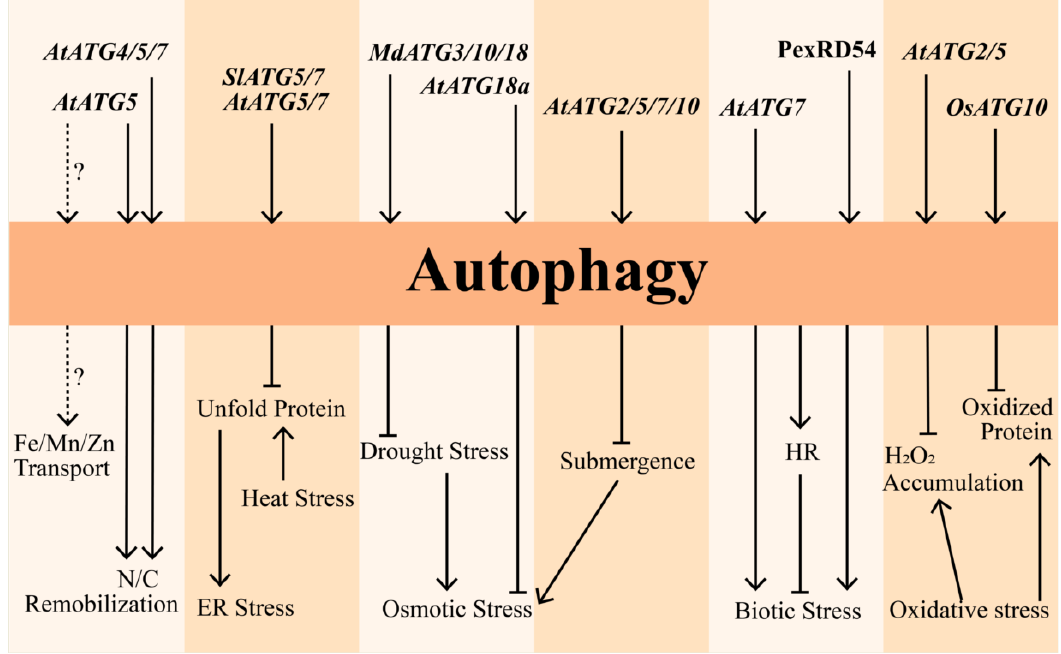
Figure 1. Regulation of stress response by AuTophaGy-related ( ATG )-mediated autophagy. Multiple ATG genes operate autophagy. AtATG5 positively regulates the nitrogen remobilization and tolerance to carbon starvation while AtATG4 and AtATG7 are known to modulate tolerance to carbon starvation. In addition, AtATG5 is also involved in regulating the homeostasis of micronutrients, such as Fe/Mn/Zn. Unfold proteins were accumulated under heat stress, which has been implicated to be degraded via the ATG5 - and ATG7 -mediated autophagy route in Arabidopsis and tomato, eventually alleviating the unfold protein-mediated endoplasmic reticulum (ER) stress. Similarly, accumulation of H 2 O 2 and oxidized proteins are also selectively turned over by the AtATG2 - and AtATG5 -dependent autophagy in Arabidopsis and the OsATG10 -dependent autophagy in rice, respectively, ultimately relieving oxidative stress. MdATG3 , MdATG10 , and MdATG18 positively enhance drought tolerance in apple, and a similar role is also found in AtATG18a . Furthermore, AtATG2 , AtATG5 , AtATG7 , and AtATG10 also play positive roles in regulating submergence response, finally mediating osmotic stress. Under abiotic stress, AtATG7 positively regulates necrotrophic fungal pathogen resistance, and pexRD54 arrests pathogen infection by boosting autophagy activity. Moreover, autophagy positively regulates hypersensitive response (HR) cell death to resist biotic stress. Solid lines represent the activation or repression with known evidence. Dashed lines represent the proposed activation or